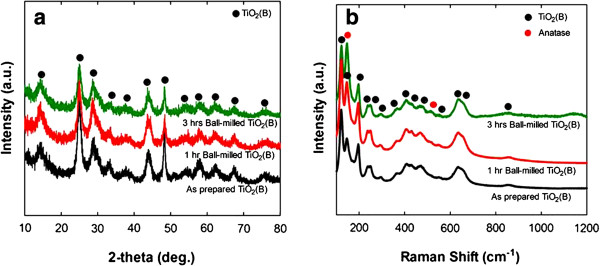
XRD patterns (a) and Raman spectra (b) of the planetary ball-milled TiO
2
(B) samples used in Figure1.